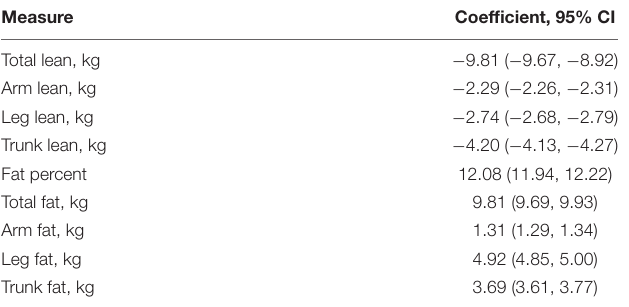
TABLE 2 | Fat and lean body mass differences in 10,537 males and 11,536 females aged 18 and older based on linear regression controlling for age, race, ethnicity, height, and weight, US, NHANES 1999–2006, all p <